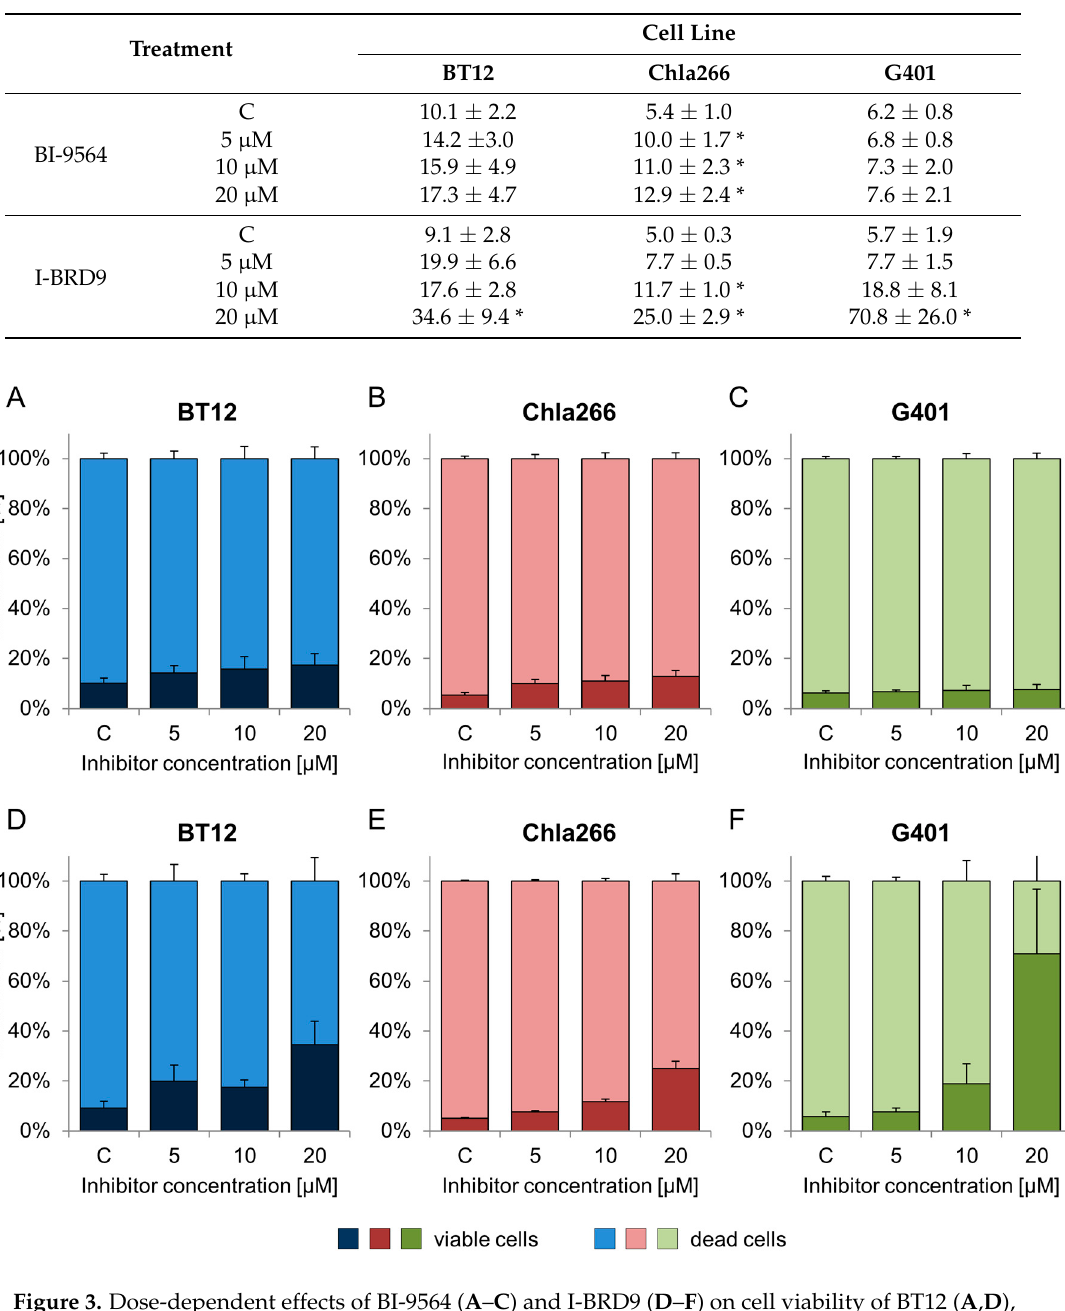
Figure 3. Dose-dependent effects of BI-9564 ( A – C ) and I-BRD9 ( D – F ) on cell viability of BT12 ( A , D